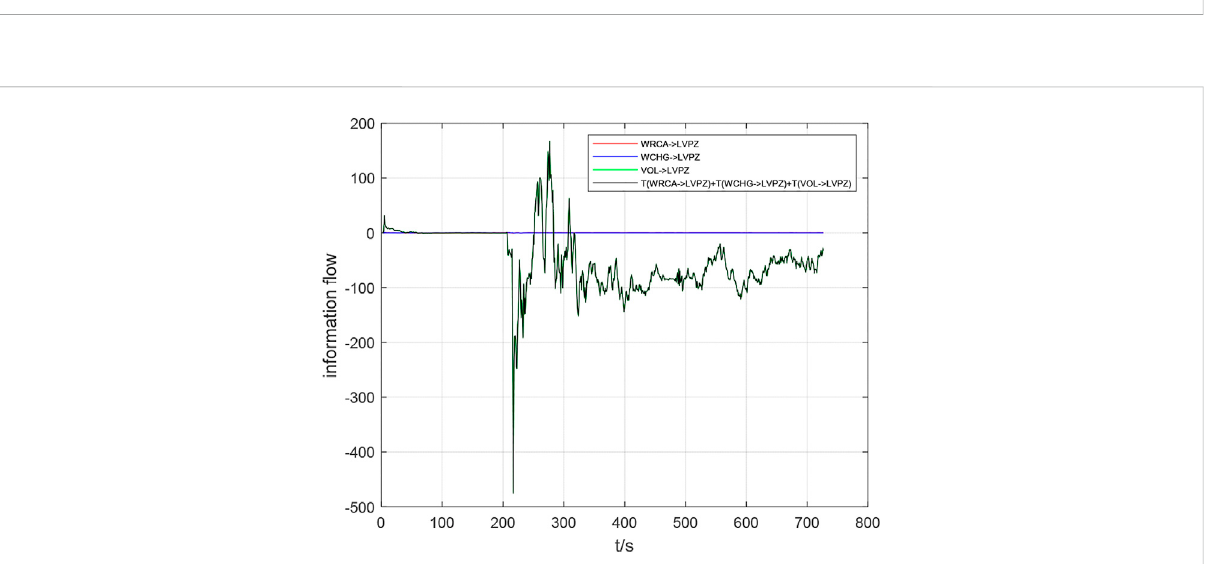
FIGURE 12 All information fl ow of MSLB-IN with 10% breach size in